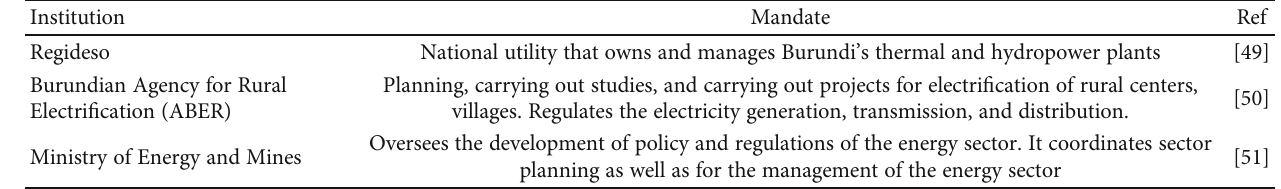
Table 13: Institutions involved in the energy sector in Burundi.